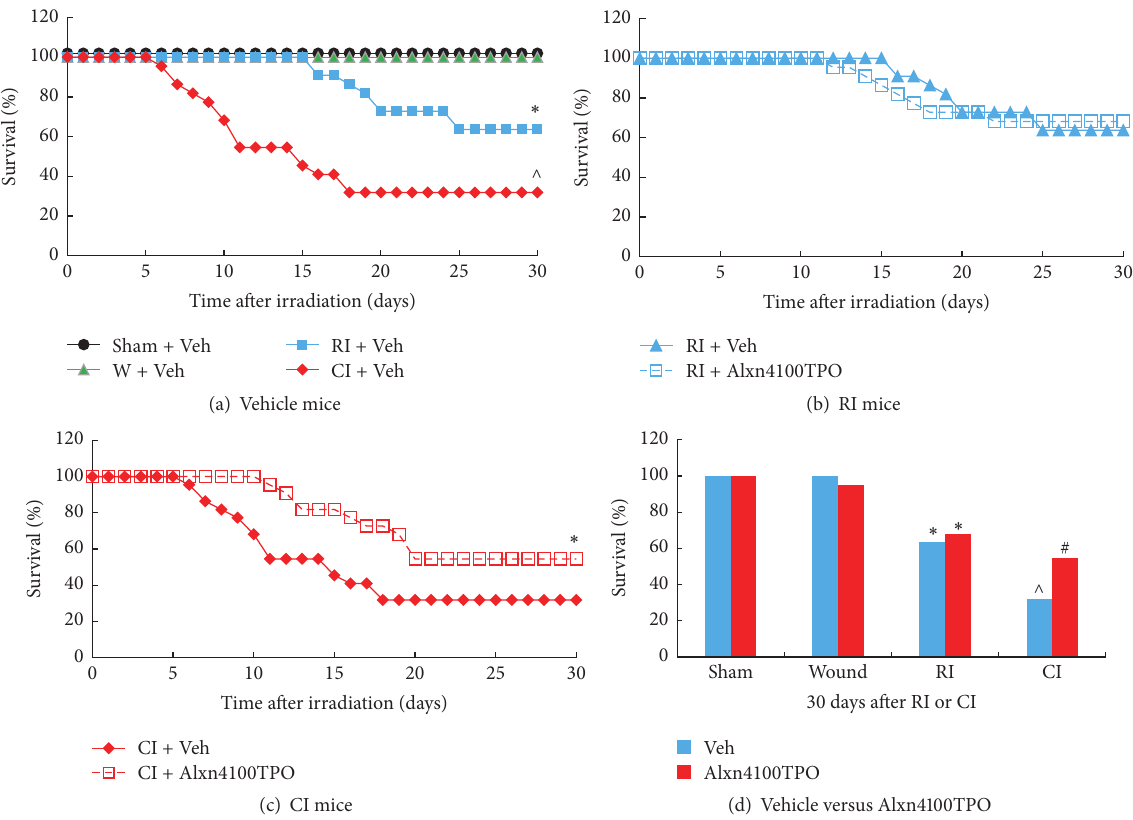
Figure 6: RI and CI decreased survival and Alxn4100TPO improved survival after CI. Animals were monitored for 30 days. 𝑁 = 19–22 per group. For panel (a): ∗ 𝑝 < 0.05 versus sham and W; ∧ 𝑝 < 0.05 versus RI. For panel (c): ∗ 𝑝 < 0.05 versus CI + Vehicle. For panel (d): ∗ 𝑝 < 0.05 versus sham and W; ∧ 𝑝 < 0.05 versus RI + Vehicle; # 𝑝 < 0.05 versus CI + vehicle. W: wound; RI: 9.5 Gy; CI: 9.5 Gy and skin